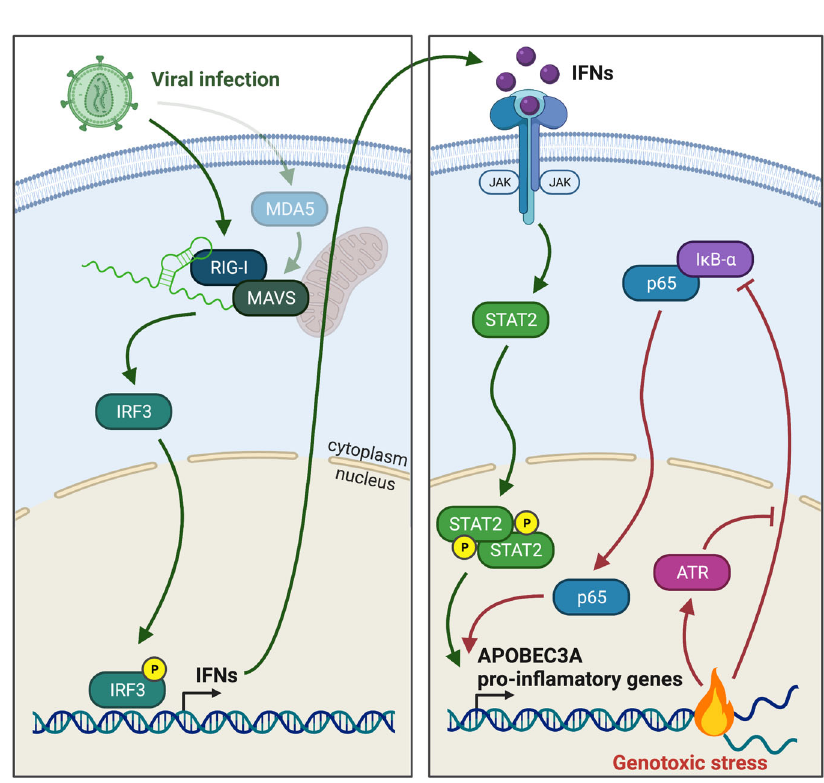
Fig. 8 Two distinct mechanisms regulate expression of A3A and pro-in fl ammatory genes. Viral infection triggers the host pattern recognition receptors RIG-I and MDA5 to promote A3A expression through the stimulation of MAVS, IRF3, and STAT2. Alternatively, genotoxic stresses lead to the activation of the canonical NF- κ B pathway to transiently upregulate A3A